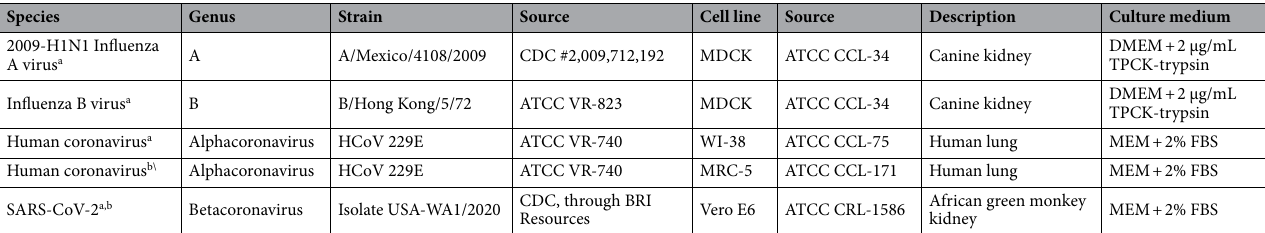
Table 1. Viruses and detector cell lines used. ATCC American Type Culture Collection, CDC U.S. Centers for Disease Control and Prevention, FBS fetal bovine serum, HCoV 229E human coronavirus 229E, MEM